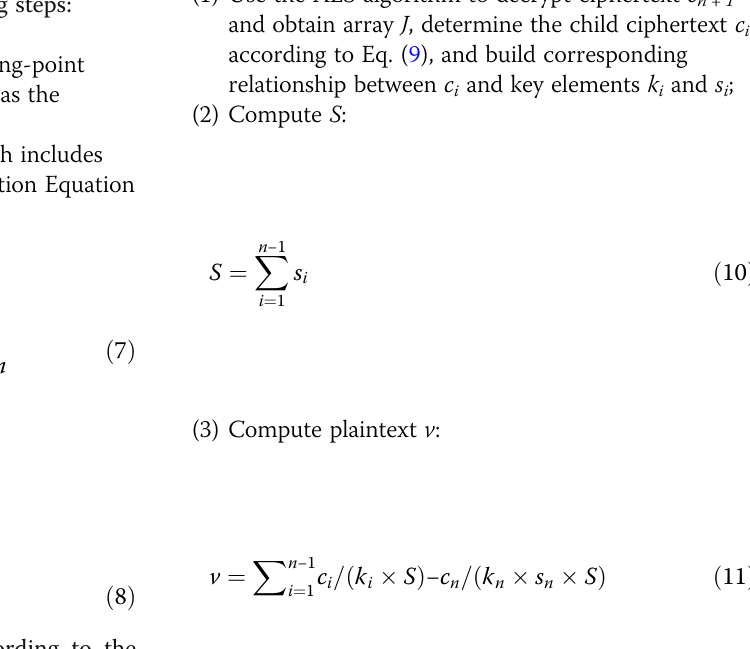
algorithm supporting floating-point operation 4.1 The proposed FFHE